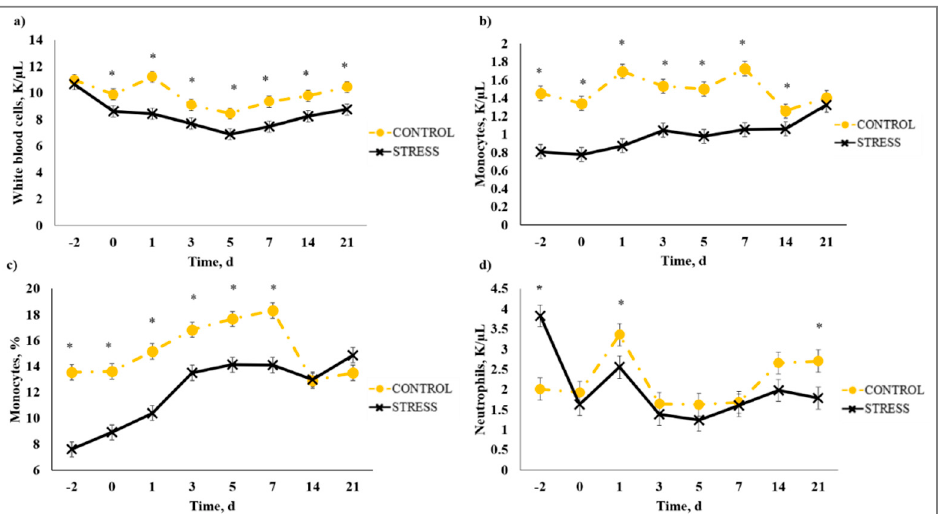
Figure 5. Effect of non-stress control (C; weaned on Day − 37; transported to West Texas A&M University research facility on Day − 21; vaccination on Day 0) and stress model implementation (S: weaned on Day − 3; transported to USDA-ARS Livestock Issues Research Unit on Day − 2; relocated to WTAMU on Day − 1; vaccination on Day 0) on: ( a ) white blood cells (WBC); ( b ) monocytes (MONO); ( c ) percent monocytes (PERMONO); and ( d ) neutrophils (NEU). Effect of stress model implementation on WBC (stress model × day effect; p < 0.01); MONO (stress model × day effect; p < 0.01); PERMONO (stress model × day effect; p < 0.01); NEU (stress model × day effect; p < 0.01). * C differs from S within day, p ≤ 0.02.